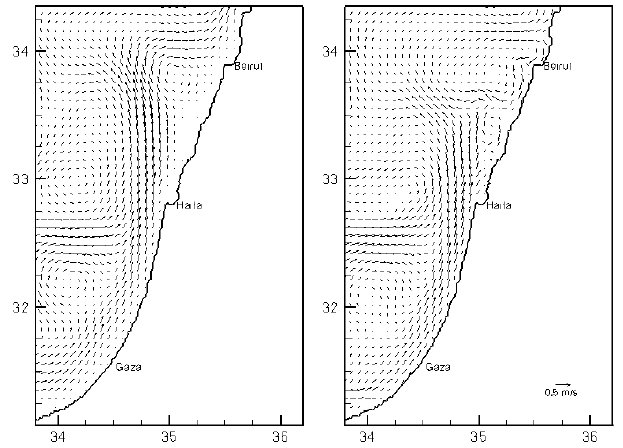
Fig. 22. Comparison of the daily mean near-surface (10m) cur- rents on 20 July 2008 from the MyOcean reanalysis, resolution ∼ 6.9km (left panel), with the downscaled field produced by a high- Figure 4.3.1 Comparison of the daily mean near surface (10 m) currents on 20 Jul 2008 from the MyOcean resolution, ∼ 1.7km, model (right reanalysis, resolution ~6.9 km, (left panel) with the downscaled field produced by a high resolution, ~1.7 km, model (right panel).